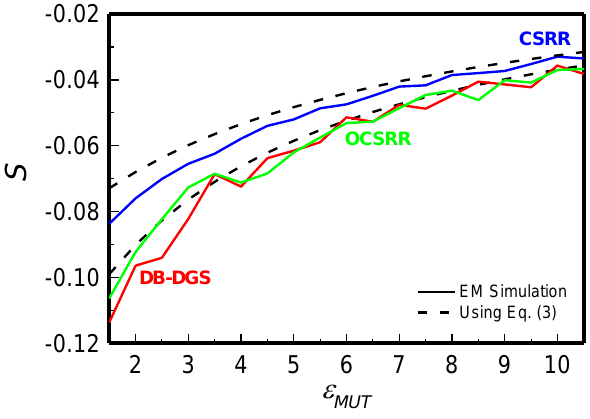
Figure 6. Relative sensitivity of the OCSRR-loaded line, as compared to those reported in [90].